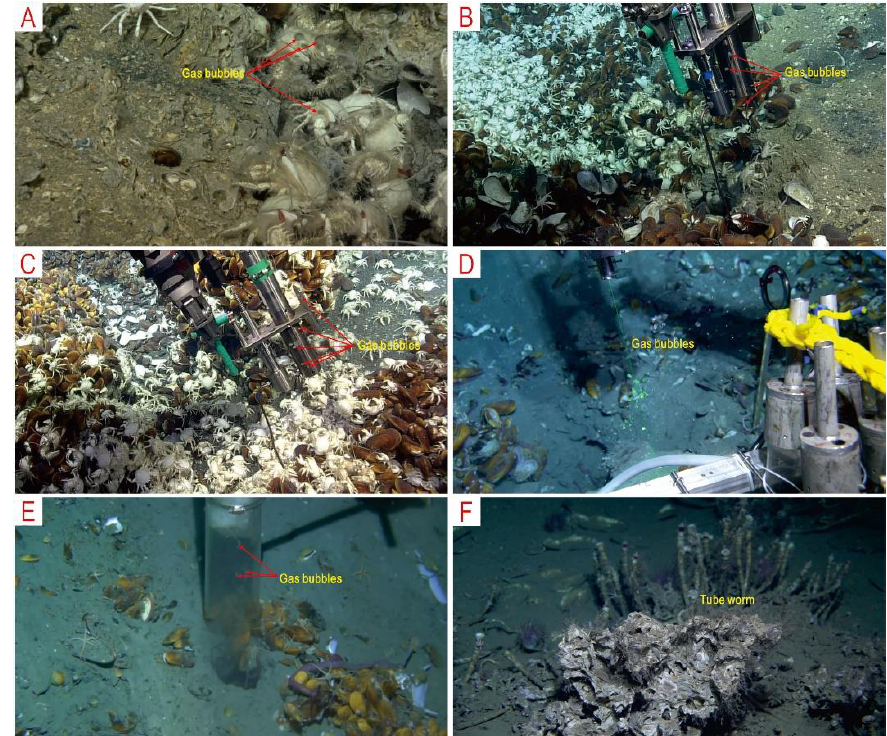
Figure 2. Frame grabs of individual cold seep vents investigated in this study. ( A – C ) Seep 1, Seep 2, and Seep 3 at Site F. The frame grabs show clearly that gas bubbles are escaping from pores in the carbonate pavements. Densely packed mussels ( Bathymodiolus platifrons ) and galatheid crabs ( Shinkaia crosnieri ) are also seen on freshly formed carbonate pavements. ( D ) Seep 1 of the Haima cold seeps. The gas bubble stream and gas hydrate slice are both clearly visible in the seawater, and packed mussels are seen scattered on the surrounding seafloor sediments. ( E ) Seep 2 of the Haima cold seeps. The frame grab from the camera shows clearly that dense streams of bubbles are escaping from the seabed. When these escaped bubbles entered the sample tube, they quickly formed gas hydrates. ( F ) Living tubeworms discovered in the Haima cold seeps.